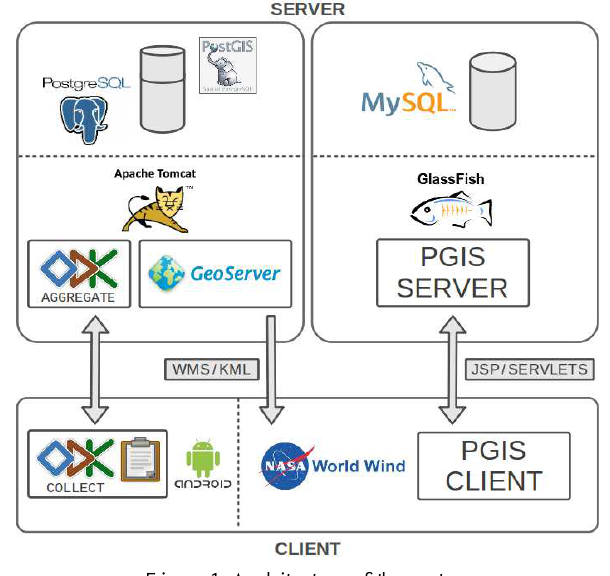
Figure 1. Architecture of the system